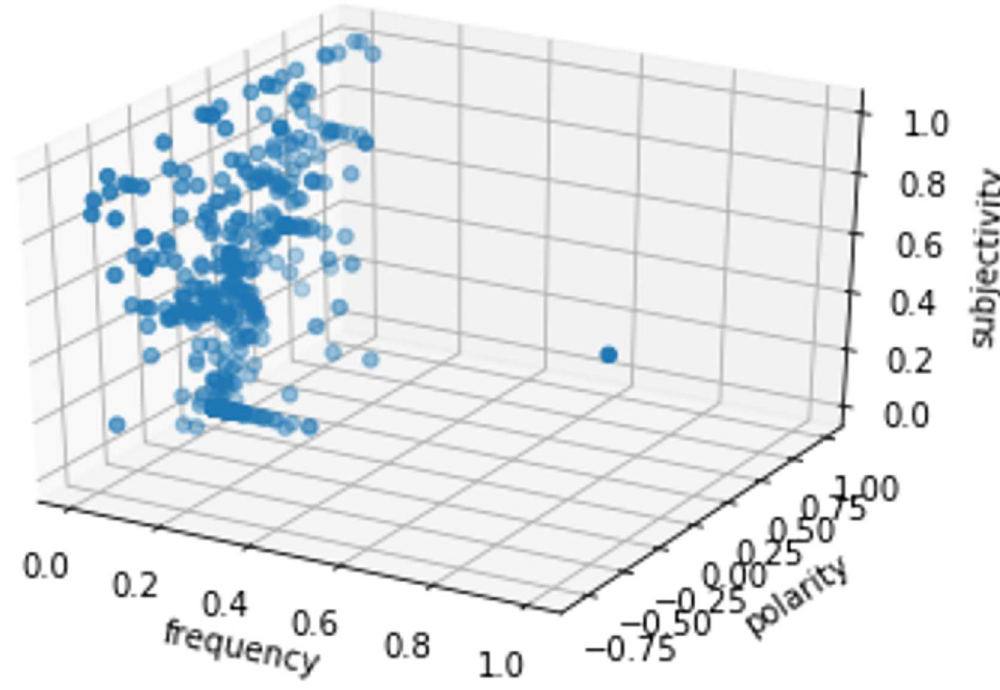
Fig 20. 3-d plot frequency, polarity and subjectivity distribution.